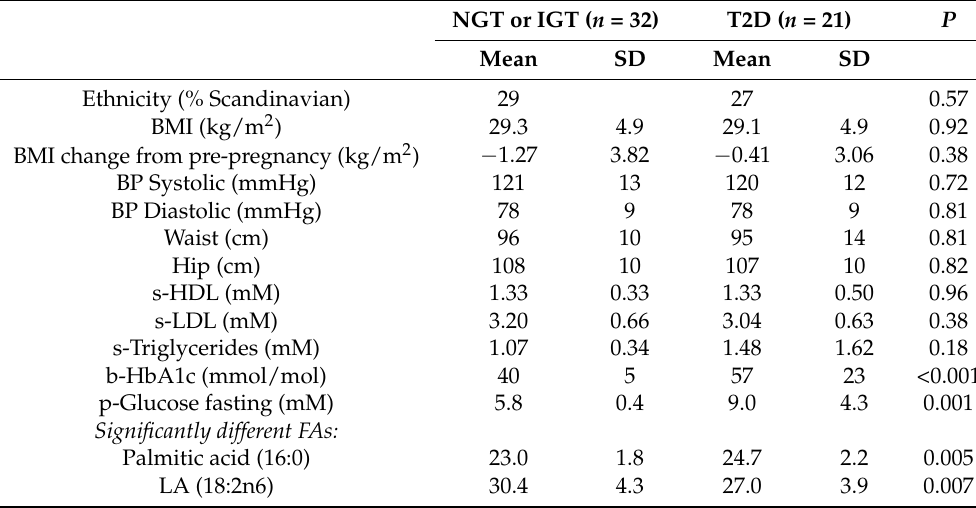
Table 6. Characteristics of the subgroup of women at high risk of developing type 2 diabetes (T2D) owing to the requirement for insulin treatment during GDM. This group was divided into women who had or had not developed T2D by 6 years after